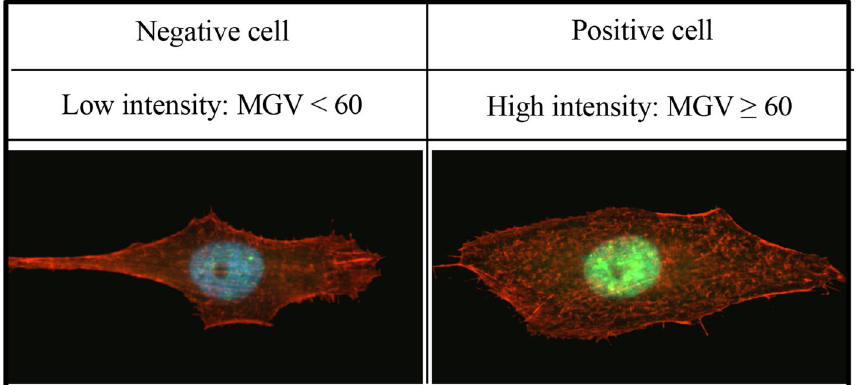
Figure 2. The mean grey value (MGV) based classification.